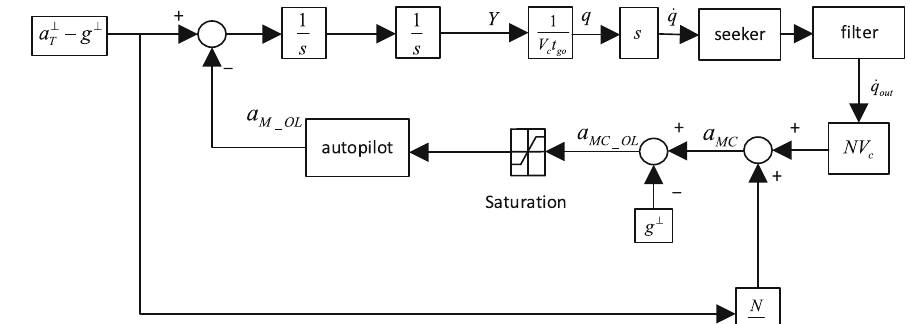
Figure 17: An Equivalent system to Figure